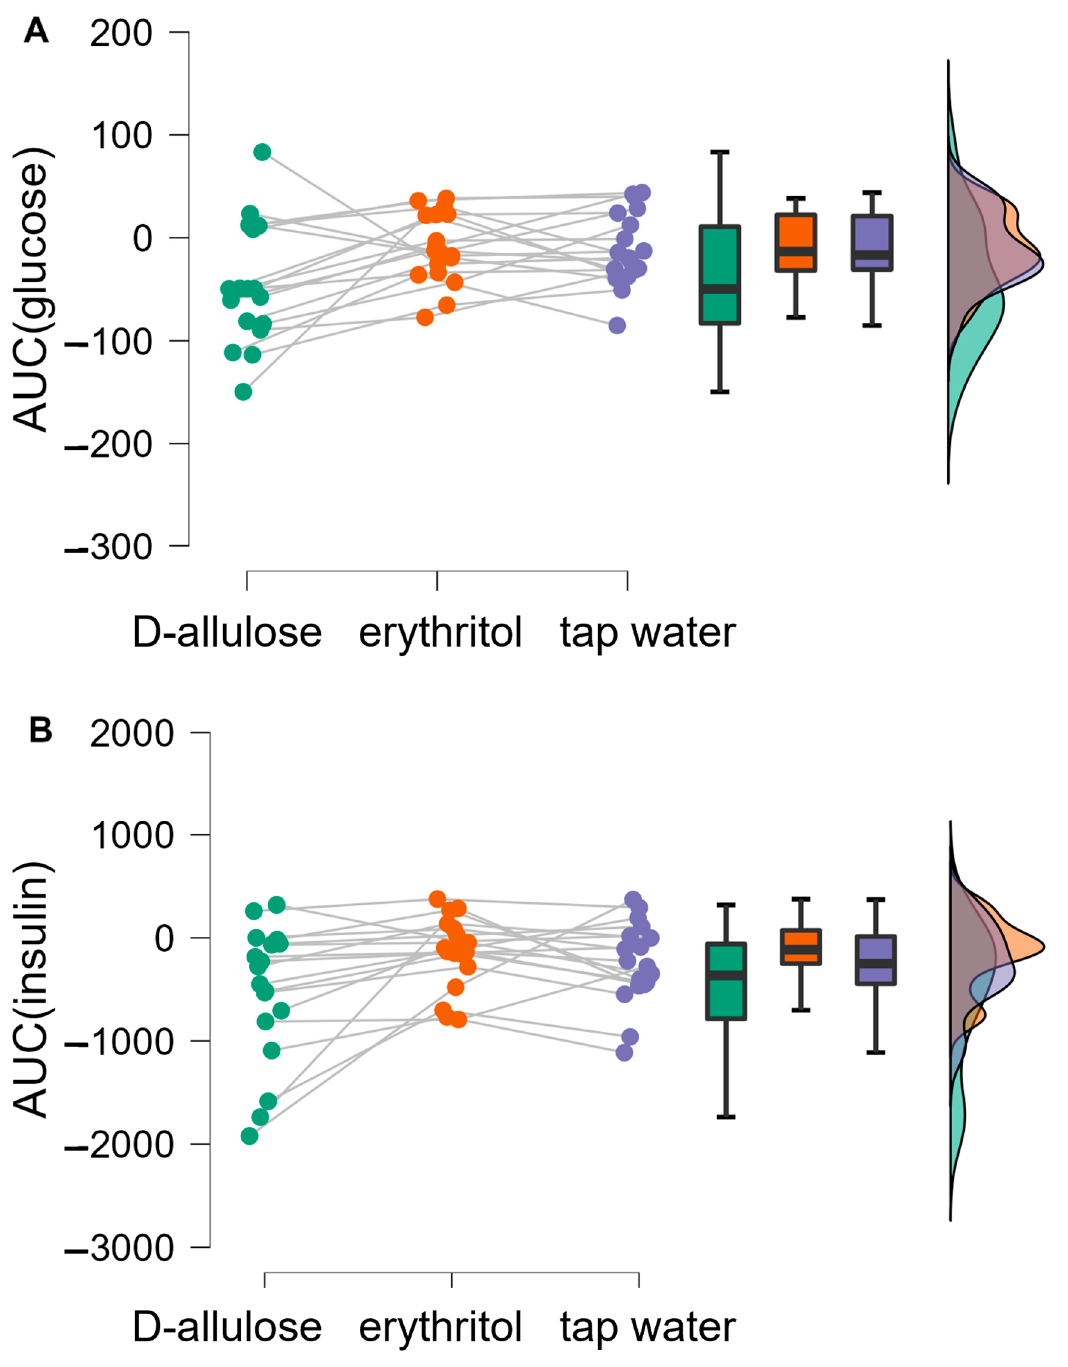
Figure 3. Raincloud plots showing the Bayesian repeated measures ANOVA on the AUC of glucose ( A ) or insulin ( B ) concentrations in response to the intragastric administration of solutions containing 25 g D-allulose (green), 50 g erythritol (orange) or tap water (purple) to 18 healthy subjects.